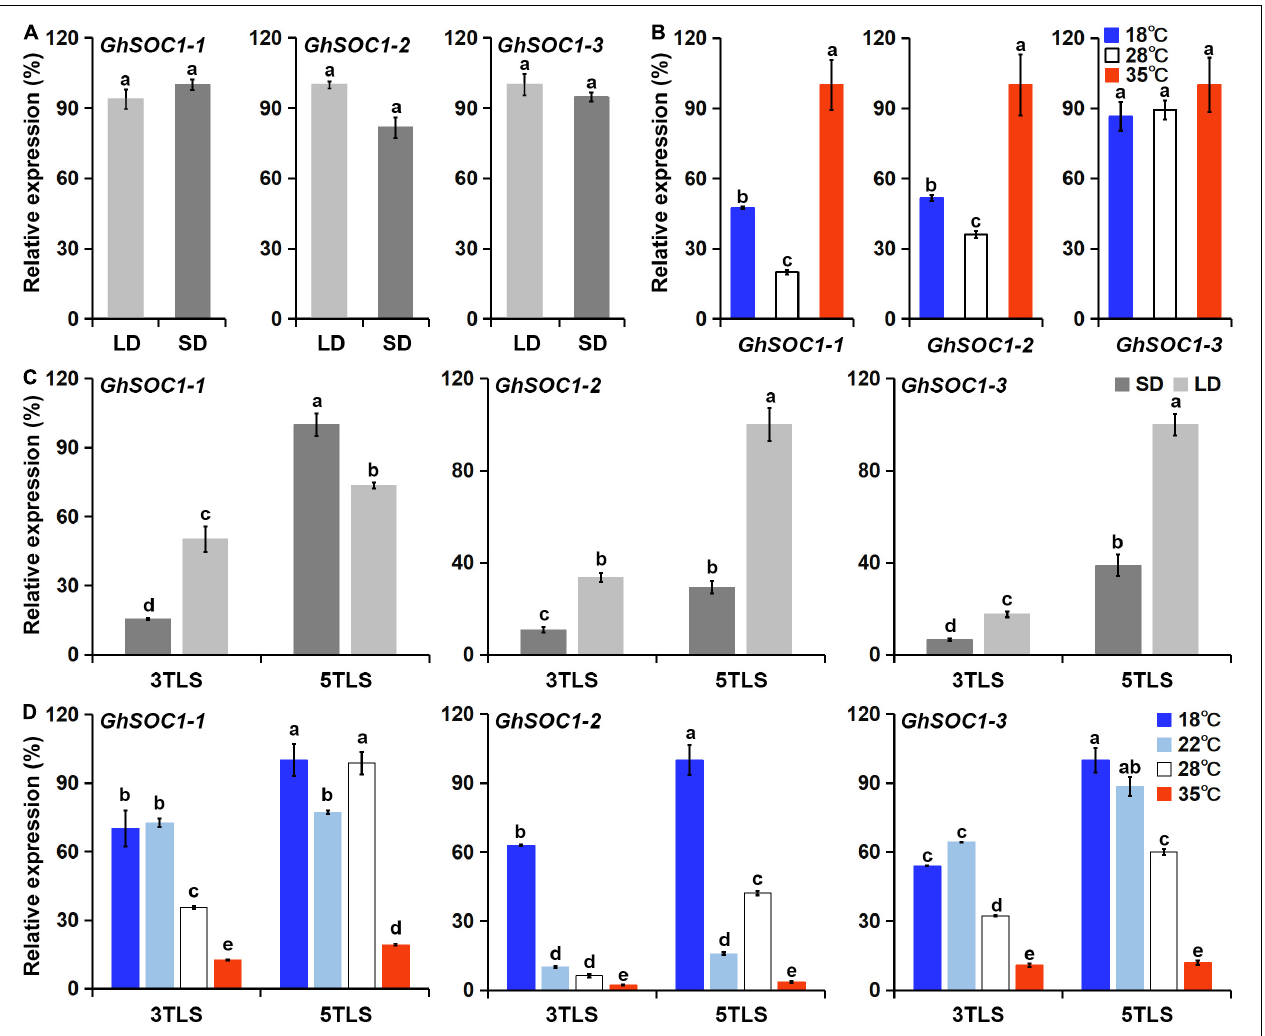
FIGURE 7 | Responses of GhSOC1s to light and temperature. (A) Quick response of GhSOC1s to day length shift from long-day to short-day for 48 h under 28 ◦ C. (B) Quick response of GhSOC1s to temperature shift for 48 h examined in seedlings grown under 28 ◦ C and long-day condition. (C) GhSOC1s expression is examined under continues long-day and short-day conditions under 28 ◦ C at 3TLS and 5TLS. (D) GhSOC1s expression is examined under different temperature conditions under long-day at 3TLS and 5TLS. The expression is normalized to GhHIS . Error bars represent the standard deviations of three biological replicates. Different letters suggest significant differences calculated by Student’s t -test ( P <